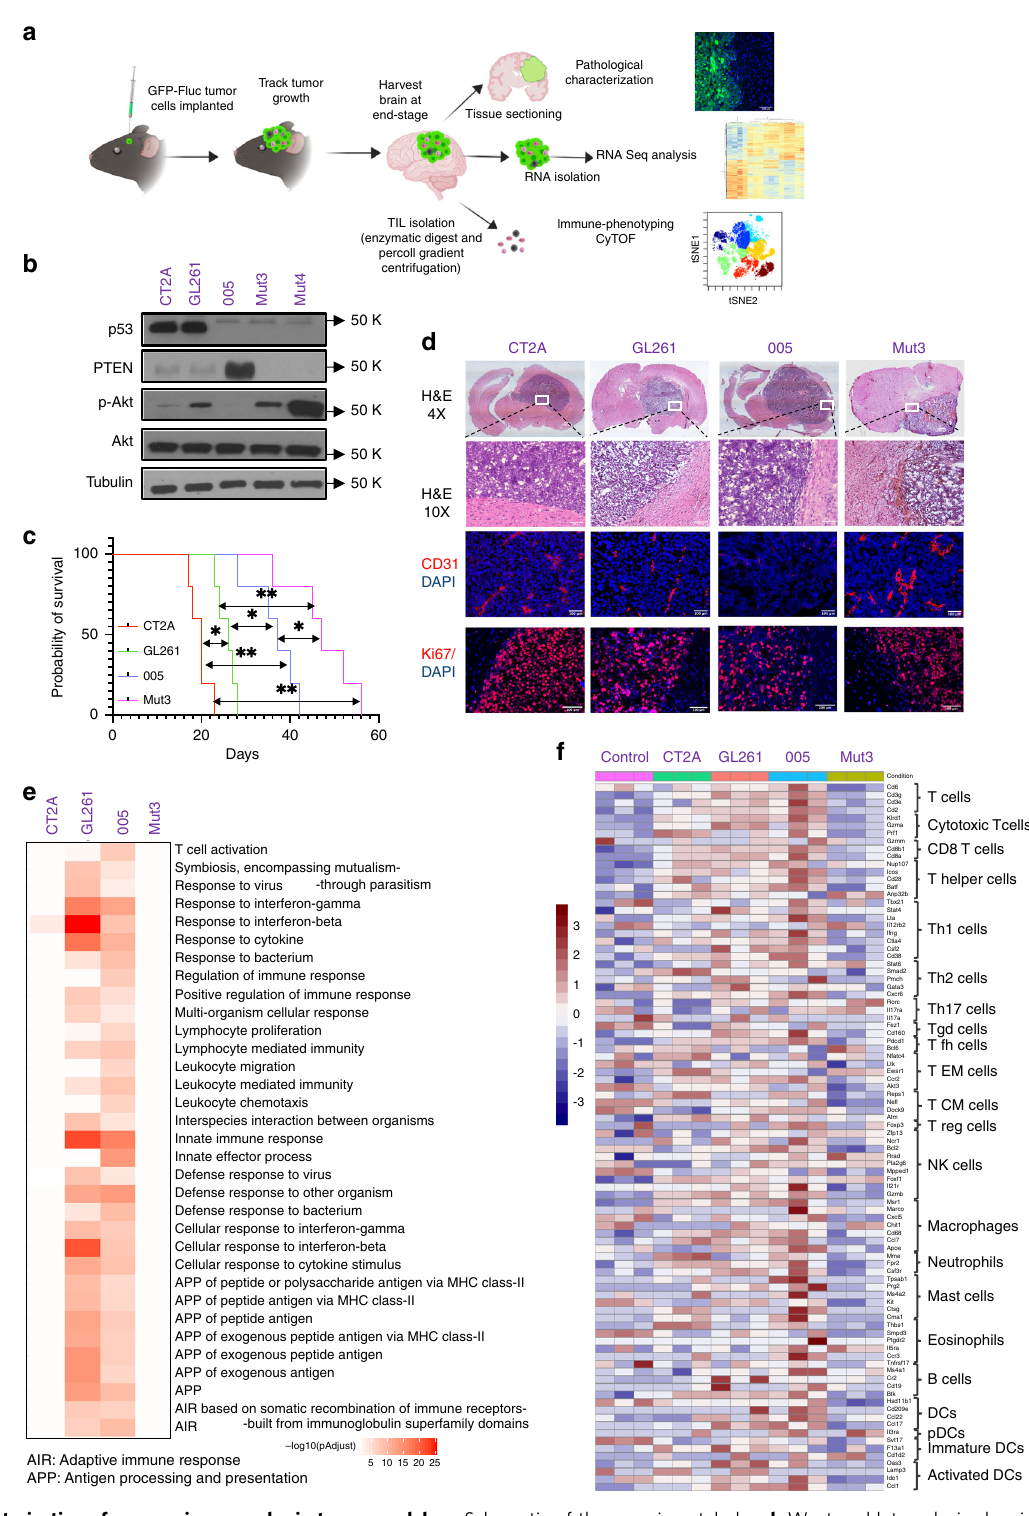
Fig. 1 Characterization of syngeneic mouse brain tumor models. a Schematic of the experimental plan. b Western blot analysis showing expression of p53, PTEN, pAKT, and AKT in the lysates prepared from mouse GBM syngeneic lines. α -Tubulin was used as loading control. Images are representative of fi ve independent experiments. c Kaplan – Meier plots showing survival of various mouse tumor models ( n = 5). Log-rank test was performed to compare each pair of survival curves. * p ≤ 0.05; ** p ≤ 0.005. d H&E (magni fi cation stitched 4× image and 10×), Ki67 and CD31 staining on the brain sections obtained from mice bearing tumors at end stage. Images are representative of three independent experiments ( e ) RNA sequencing analysis on the RNA isolated from end-stage tumors or control brains of C57BL/6 mice ( n = 3 mice per group). Pathway enrichment analysis was performed, and the p -adjusted values were plotted for each tumor type for immune-related pathways that appeared in the top 25 enriched pathway list as shown in Supplementary Figs. 3 and 4. f Heatmap of differential expression of genes associated with immune cell types in different tumor types plotted as z -score of normalized gene expression for each gene. a was created by authors using biorender tools